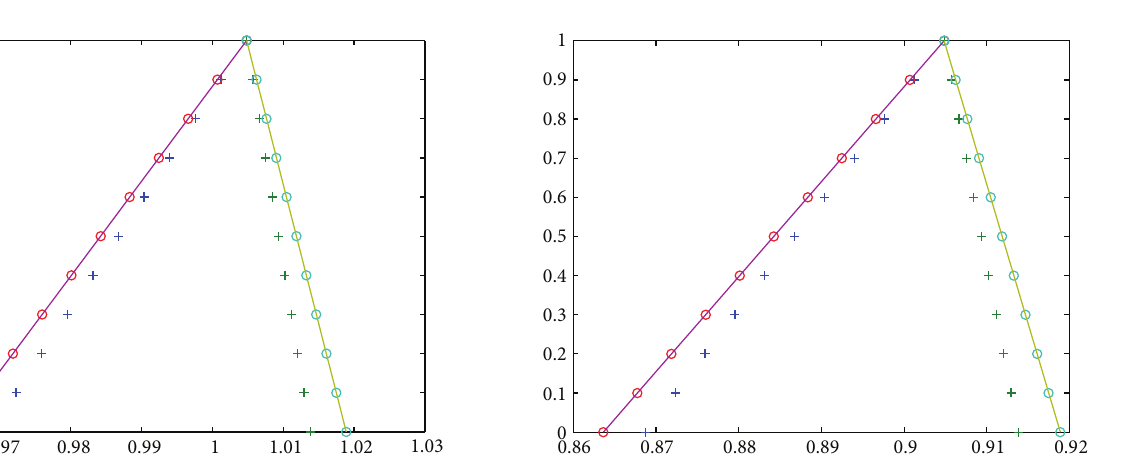
Figure 2: (-) Exact solution, ( ∘ ) Trapezoidal, and (+) Midpoint approximated